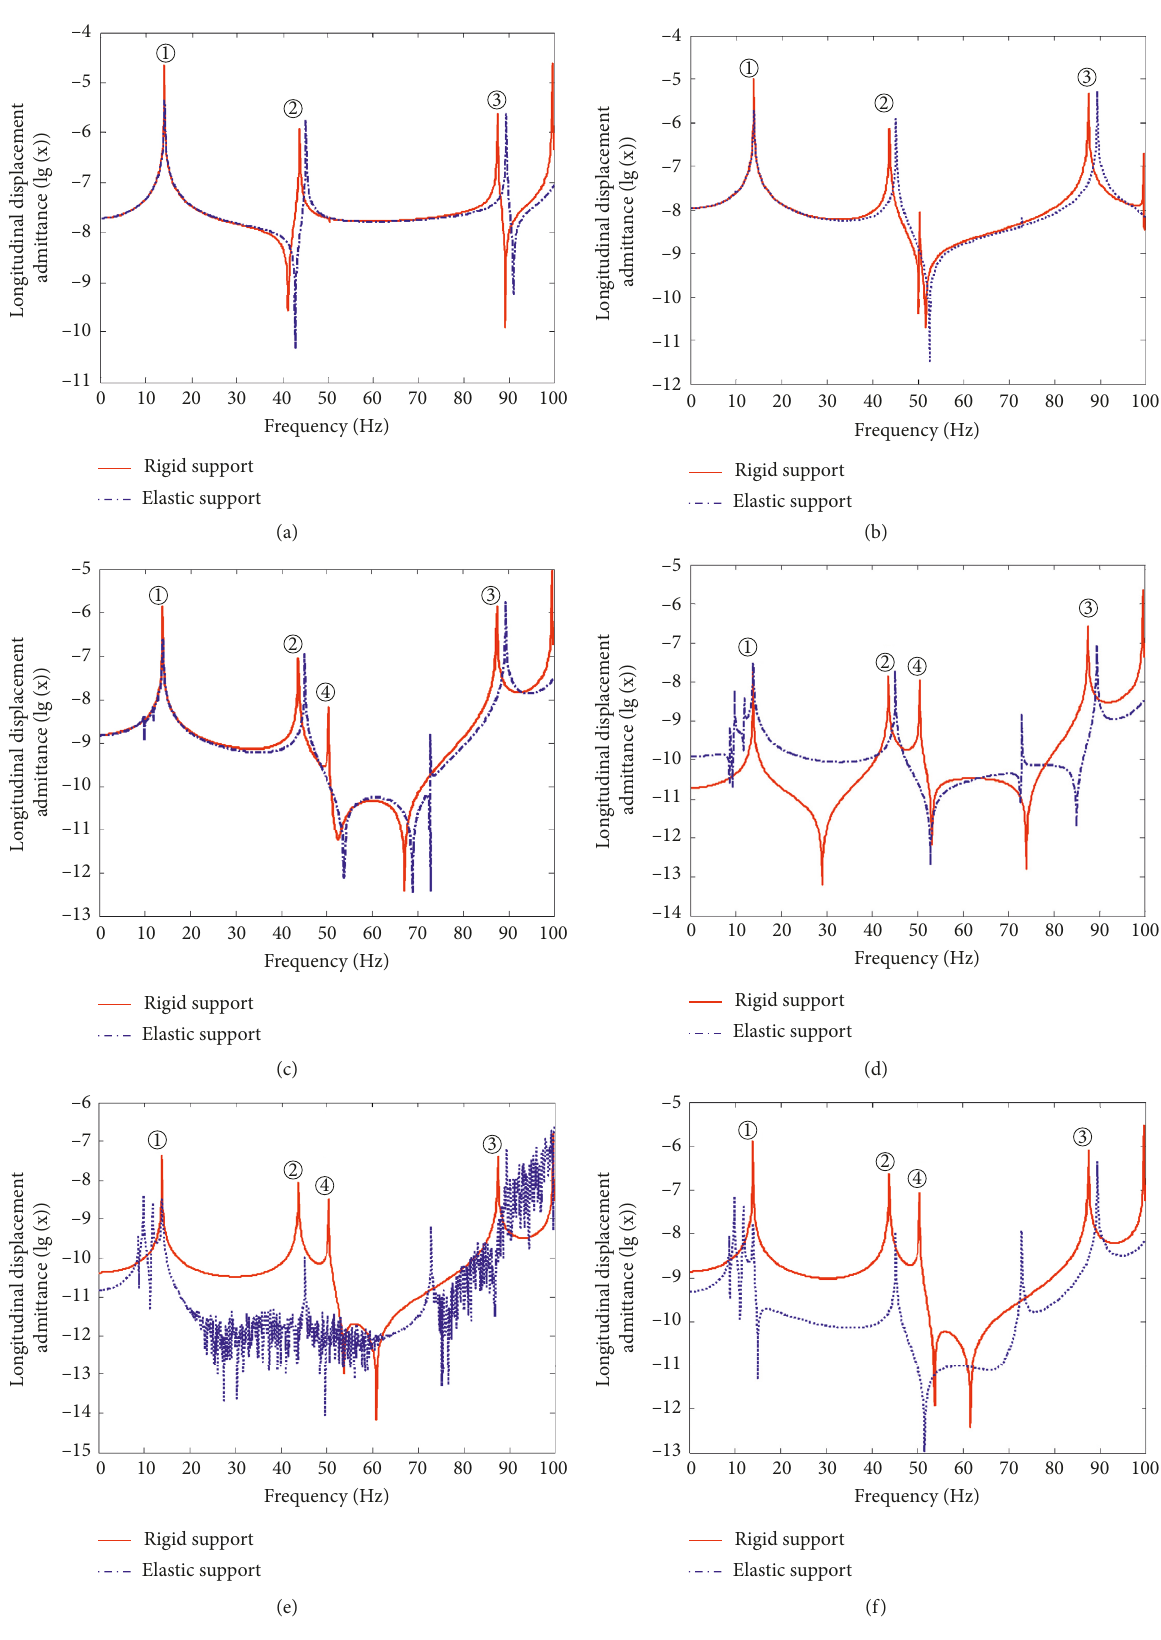
Figure 10: Vertical displacement admittance at each point of the coupling system. (a) 1#. (b) 2#. (c) 3#. (d) 4#. (e) 5#. (f) Thrust bearing